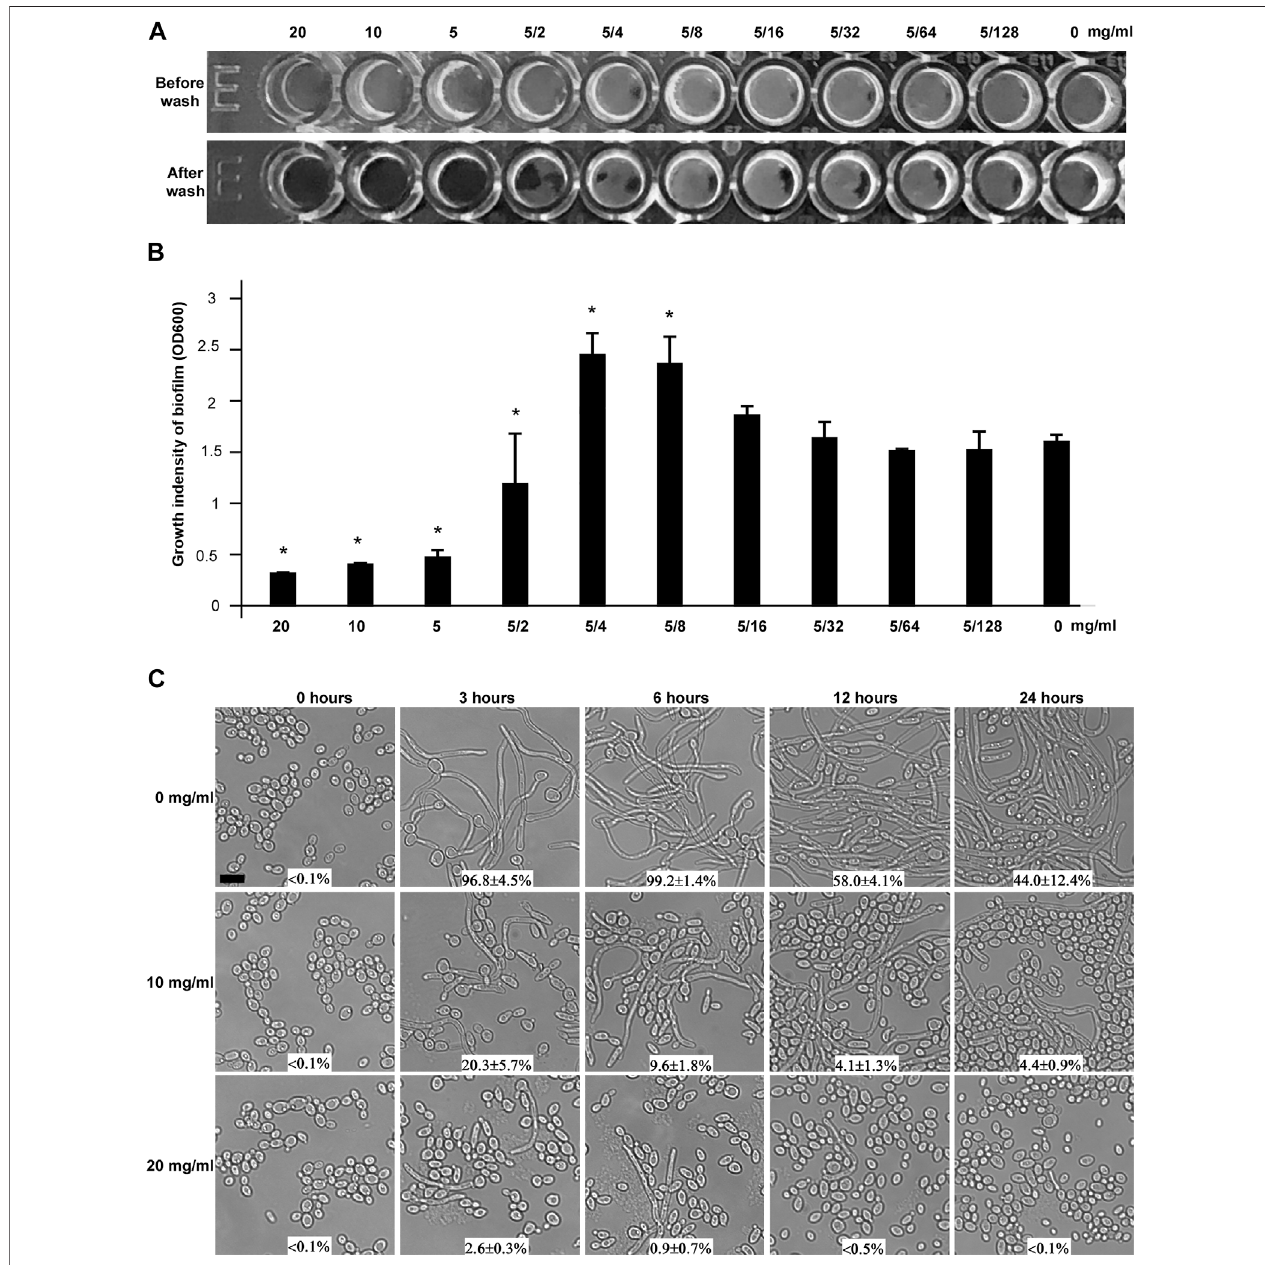
FIGURE4| TheeffectsofCHGXonbio fi lmformationandyeast-to-hyphaltransitionby C.albicans . (A) Bio fi lmformation.TheminimalinhibitoryconcentrationofCHGX water-extractforbio fi lmformationwasdeterminedina fl at-bottom96-wellplatebythemicrodilutionmethod.SC5314cellswereusedforrepresentativestrainof C.albicans. 1 × 10 5 cells ofSC5314were incubatedwithdifferent concentrationsofCHGXwater-extract(20 – 0.04 mg/ml)ina 200 μ lSpidermedium per wellfor 3 dayswithshaking at 37 ° C.Theplateswereimagedbeforeandafterbeinggentlywashedwith1×PBS,andthreebiologicalrepeatswereperformed. (B) Thegrowthintensityofbio fi lm.Cells adhered to the bottoms of 96-well plates were treated with 10% trypsin, washed, collected and resuspended in total 600 μ l PBS. The cells density (OD600) was read with Synergy4Gene5platereaderforquantitationofbio fi lm.One-wayanalysisofvariance(ANOVA)wasusedtocomparedifferencesbetweenCHGXwater-extracttreatedand untreatedsamples(control)asindicated;*, p < 0.05. (C) Yeast-to-hyphaltransition.Yeastcellsof C.albicans (SC5314,2×10 6 cells/ml)weretreatedwith0,10or20 mg/ml CHGX water-extract at 37 ° C in Lee ’ s glucose medium supplemented with 10% FBS. The cellular morphology and the percentage of hyphal cells were determined by microscopic observation at 0, 3, 6, 12 and 24 h. Three biological repeats were performed (scale bar, 10 μ m).